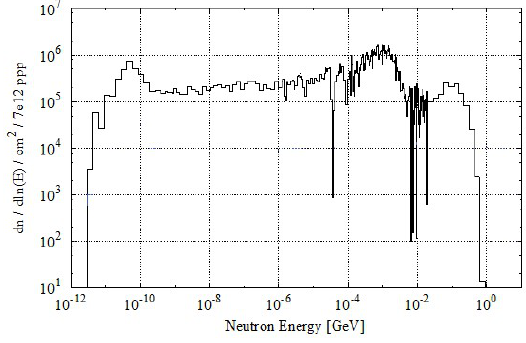
Fig. 1. n -fluence in